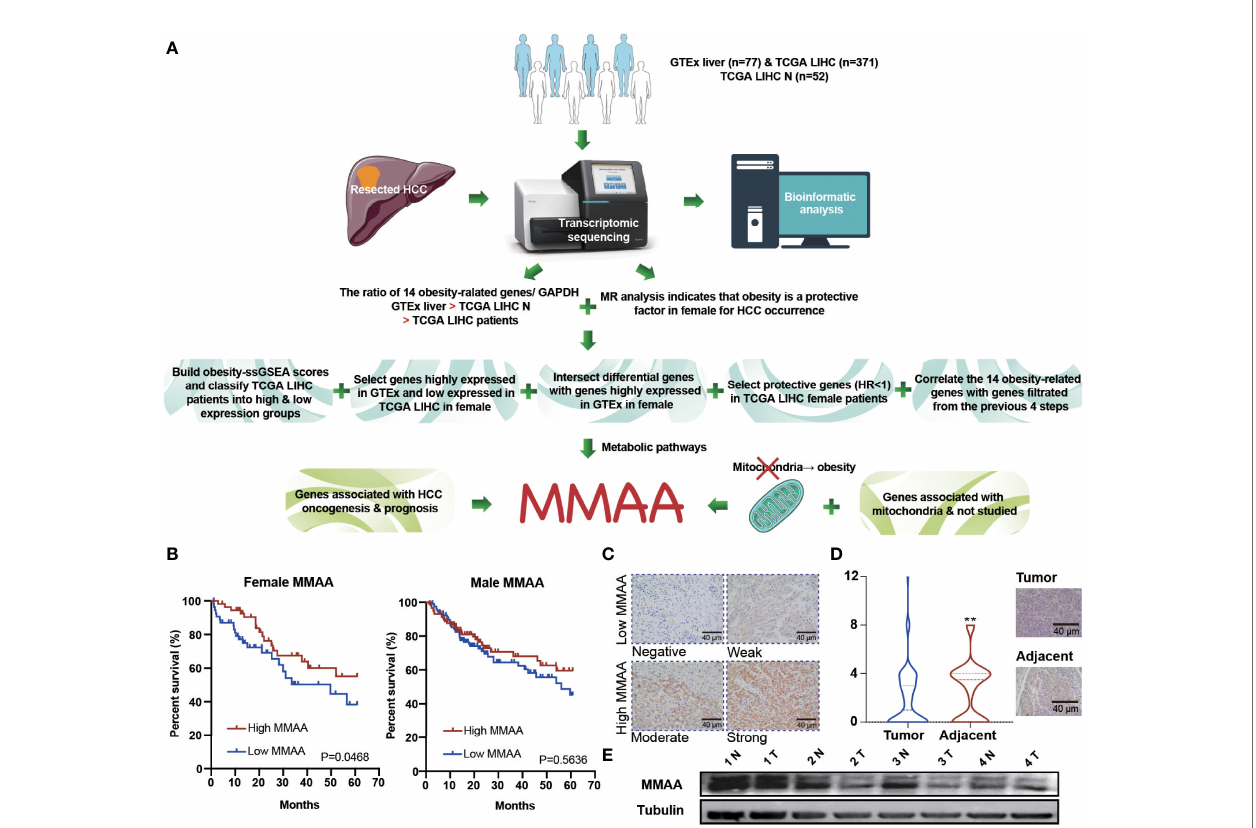
FIGURE 2 | The obesity differential gene MMAA is a positive indicator in the prognosis of HCC. (A) A fl owchart elucidating the screening criteria for obesity differential genes. (B) MMAA was associated with better outcomes in female HCC patients but not in male HCC patients. (C) Immunohistochemical staining of MMAA in HCC patients in terms of negative, low, moderate and high expression. (D, E) MMAA was highly expressed in adjacent tissues compared with tumoral tissues in HCC (scale bar, 200 µm and 40 µm). (*P < 0.05, **P < 0.01, ***P < 0.001; three biological repeats per